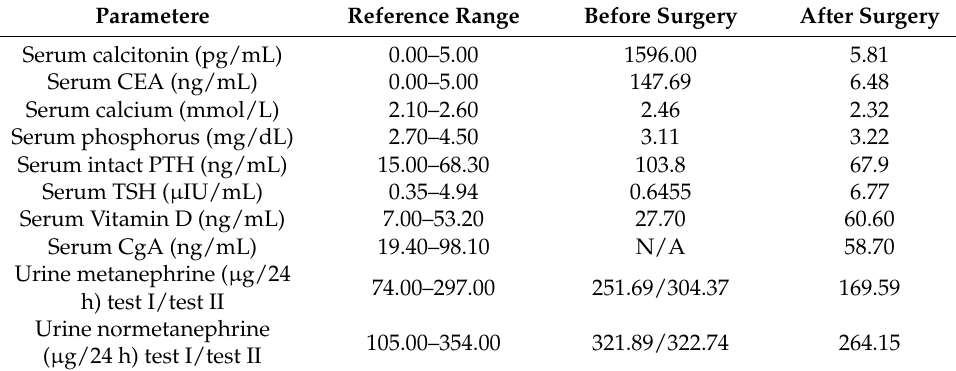
(Table 1). Table 1. Laboratory findings before and after thyroidectomy in a patient with a germline C634R RET mutation identified at the age of 71